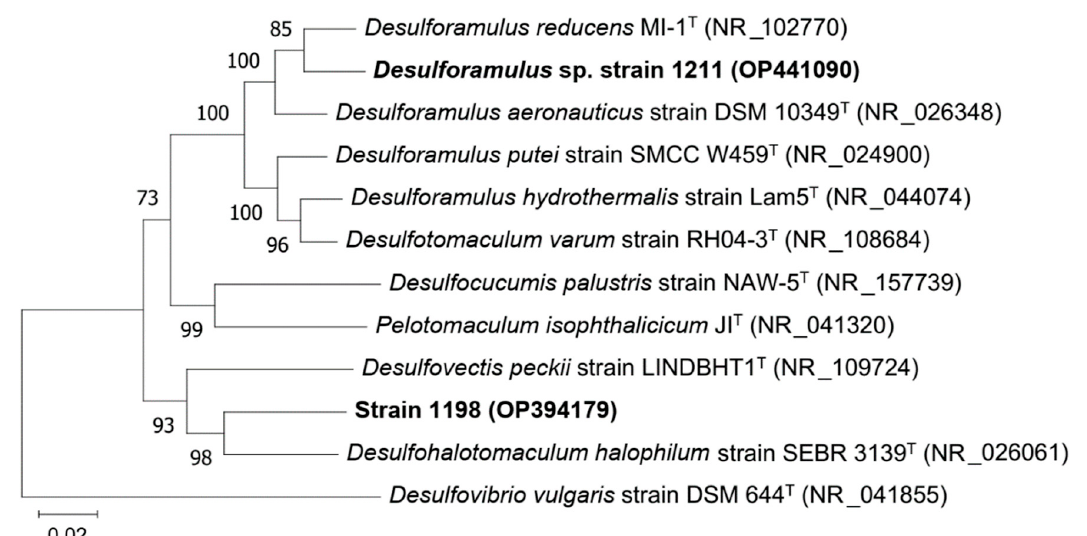
Figure 5. 16S rRNA gene-based neighbor-joining tree showing the phylogenetic position of strains 1211 and 1198. The percentage of replicate trees in which the associated taxa clustered together in the bootstrap test (1000 replicates) are shown next to the branches. The evolutionary distances were computed using the maximum composite likelihood method and are in the units of the number of base substitutions per site. All ambiguous positions were removed for each sequence pair (pairwise deletion option). There were a total of 1658 positions in the final dataset. Evolutionary analyses were conducted in MEGA11.